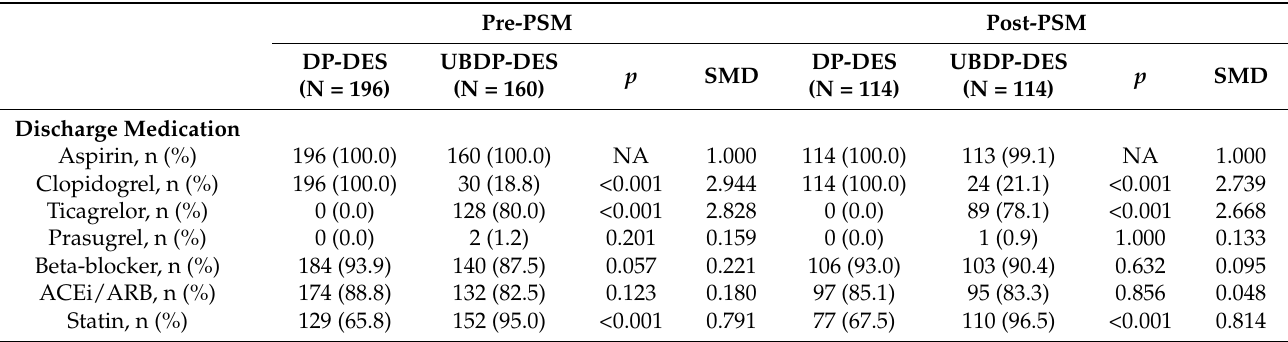
Table 3. Discharge medications pre- and post-PSM.